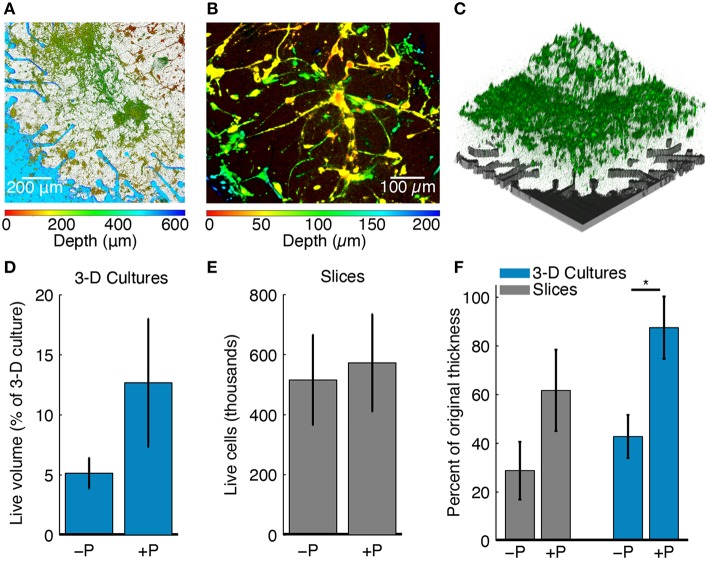
Effects of perfusion on culture health. (A) Confocal z-stack through the full 3-D cell culture thickness projected onto a single plane. The color bar below the figure indicates the z-location of live stained cells across the culture thickness. The culture was 500 μm thick at plating and cell depth is shown at 6 DIV. Perfusion maintained good cellular viability and 3-D cell culture thickness. (B) A depth-colored projection of a perfused 3-D cell culture showing cells that have grown in three dimensions. (C) 3-D rendering of the confocal z-stack in (A) taken through the full culture thickness. Live cells stained with an AM dye are shown in green. The location of the pMEA with corresponding perforations and recording sites is shown for reference in gray color. (D) Live cell volume fraction for perfused (+P, N = 4) and unperfused (−P, N = 5) 3-D cell cultures as a percentage of the original plating volume. The blue bars represent the mean value and the error bar range is mean ± SEM. (E) Live cell density for perfused (+P, N = 4) and unperfused (−P, N = 4) brain slice cultures. Slices were pooled from all experiments and normalized by original thickness at plating. The gray bars represent the mean value and the error bar range is mean ± SEM. (F) Final culture thicknesses as a percentage of the thickness at plating for perfused (+P, N = 4) and unperfused (−P, N = 4) slices and 3-D cell cultures (+P, N = 4; −P, N = 5). Gray and blue bars are represent the mean and the error bar range is mean ± SEM. When perfused, both slices and 3-D cell cultures retained more of their thickness at the end of the experiment (*P < 0.05, Wilcoxon rank-sum test). The maximum thickness was taken, which could be greater than the intended thickness at plating due to unevenness at the top surface (see Methods).